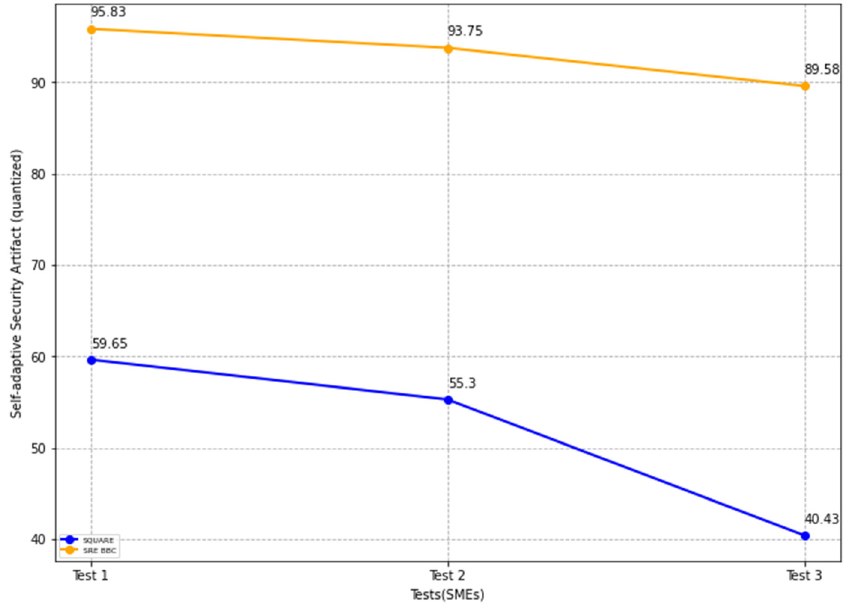
Figure 21. The comparison of quantified self-adaptive security evaluation quality for SQUARE and SRE_BBC (Replicated Study).